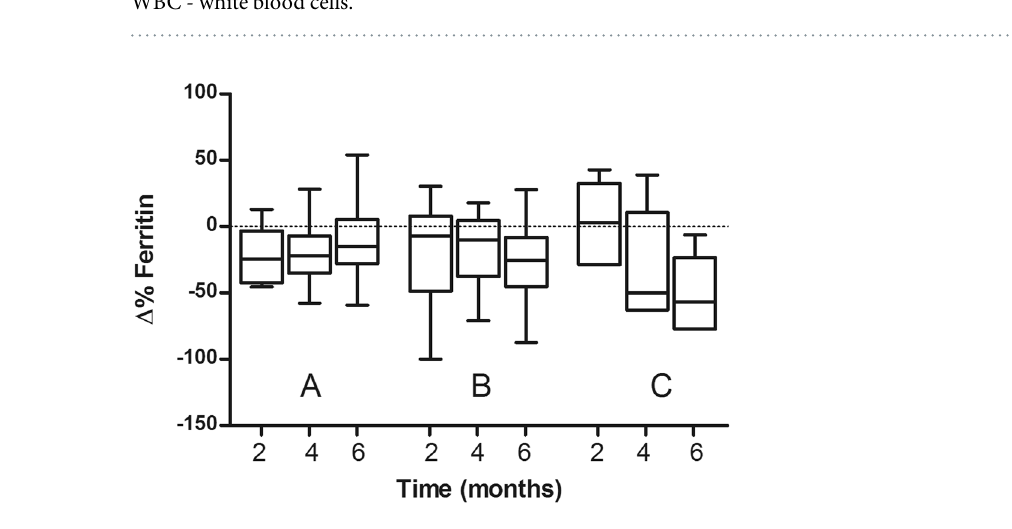
Figure 4. Percentage change in the median plasma ferritin values of PD patients receiving placebo ( A , n = 8), 20 ( B , n = 6) or 30 ( C , n = 5) mg/kg/deferiprone for 2, 4 and 6 mg of treatment. Values are presented in box plots with whiskers representing the minimum and maximum